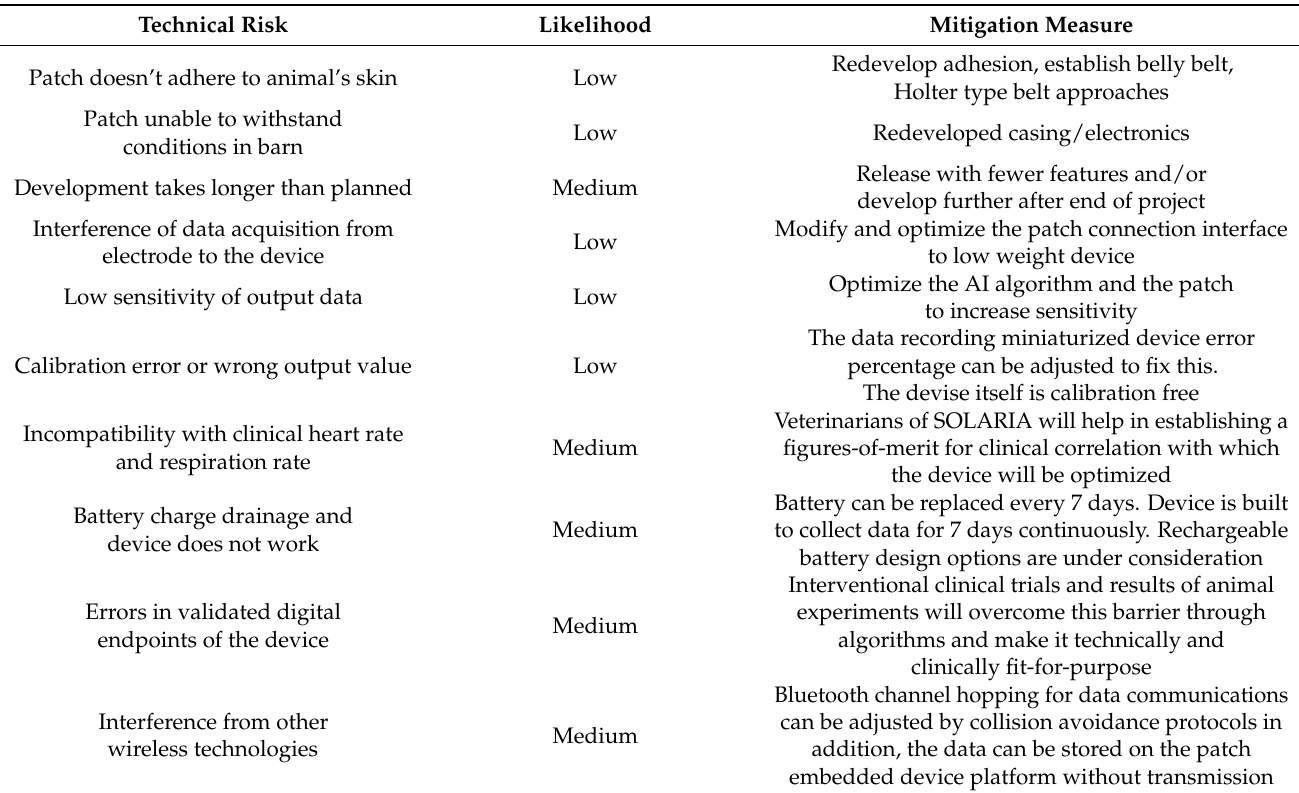
Table 1. Mitigation measures for overcoming technological risks during the data collection